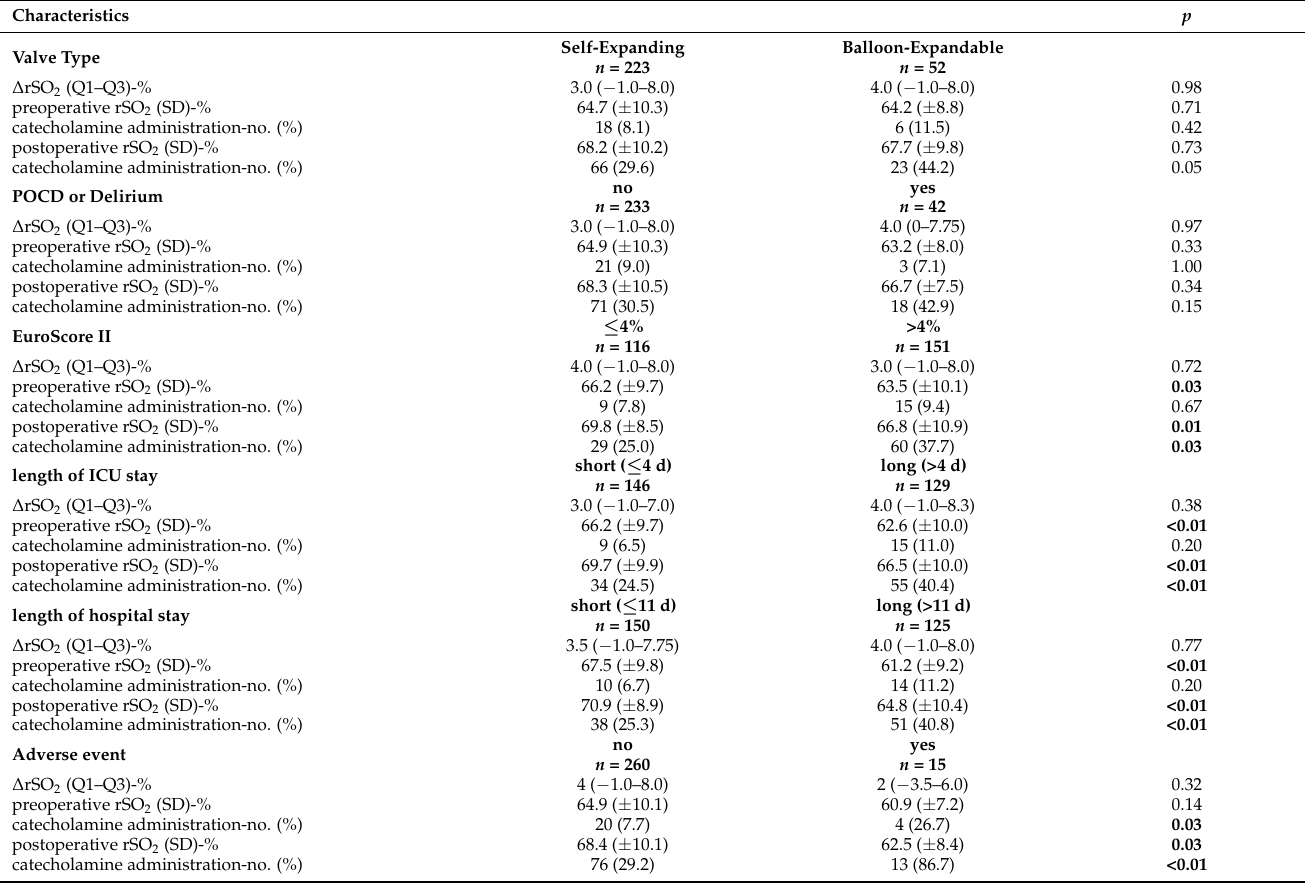
Table 5. Subgroup analysis revealed lower rSO 2 and higher need for catecholamines in patients with higher EuroScore II, longer ICU and hospital